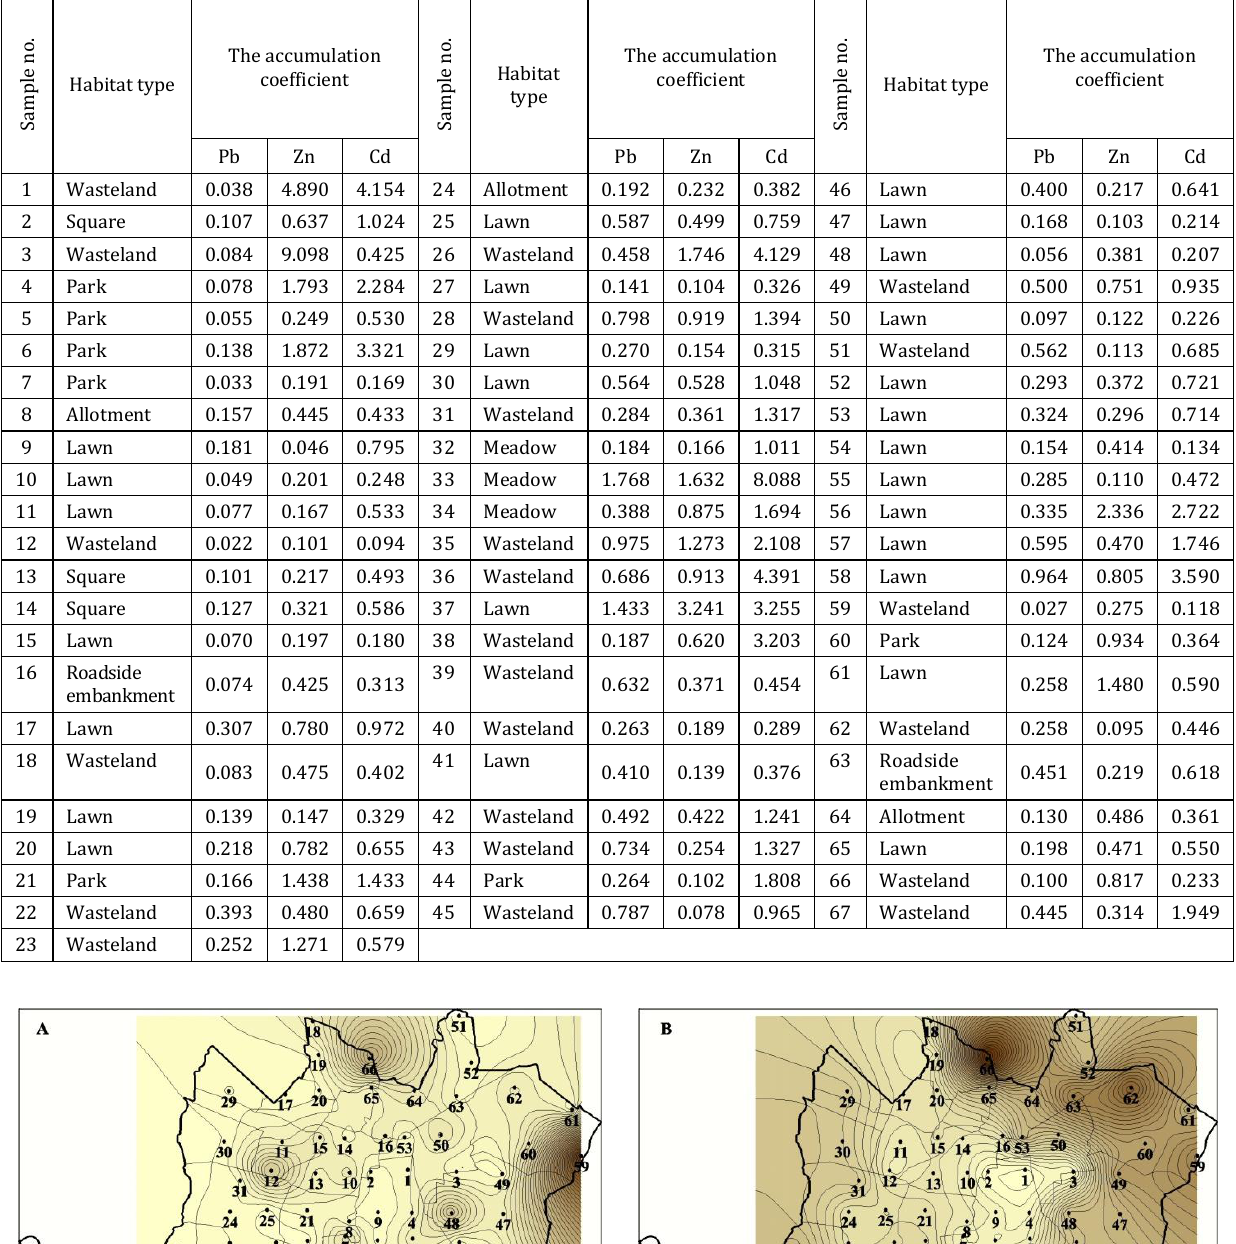
Table 1. The accumulation coefficient in the leaves of Taraxacum officinale collected within the city of Katowice